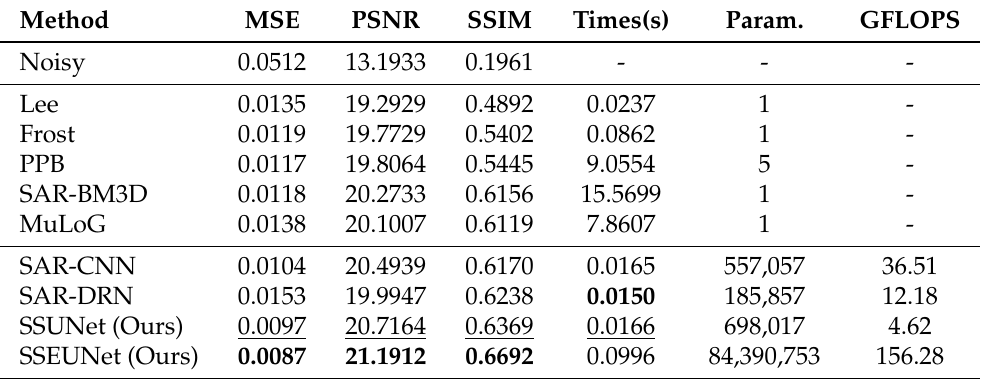
Table 2. Numerical results on simulated single-look